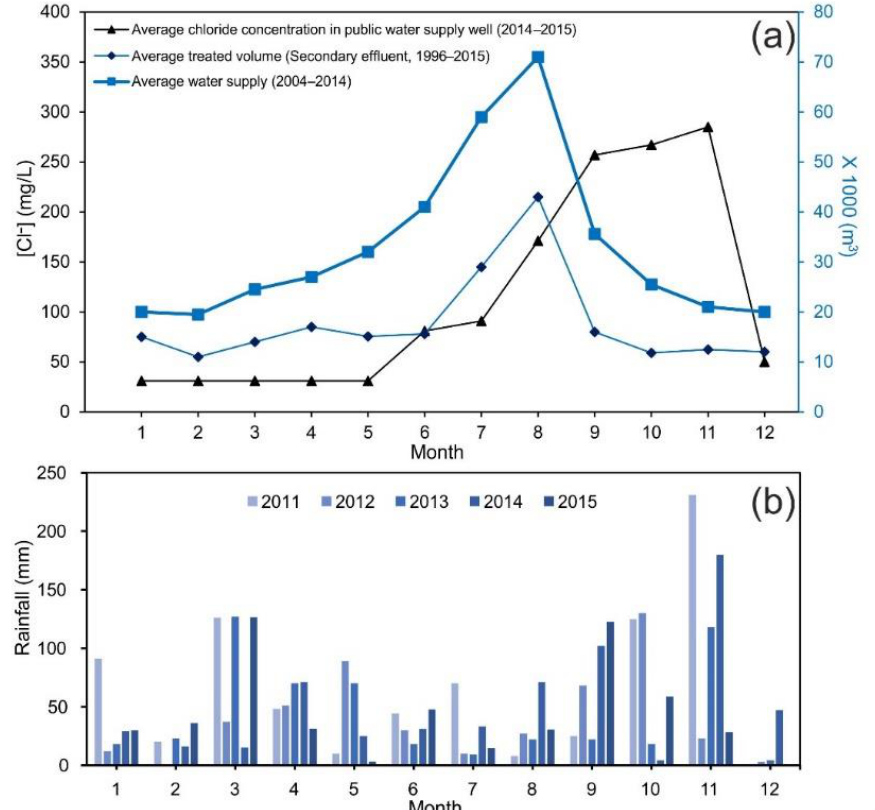
Figure 2. ( a ) Seasonal fluctuations of treated and abstracted water volumes and measured chloride concentration in Port de la Selva’s public water supply well [39]. The graph shows the correlation between water demand and wastewater generation and the deferred effect between maximum exploitation and salinization of the water supply well. The dashed line represents the chloride concentration limit defined by the Spanish sanitary guidelines for the quality of water for human consumption [37]; ( b ) rainfall for the period 2011–2016. The summer season corresponds to the dry months of the year and the highest water demand.